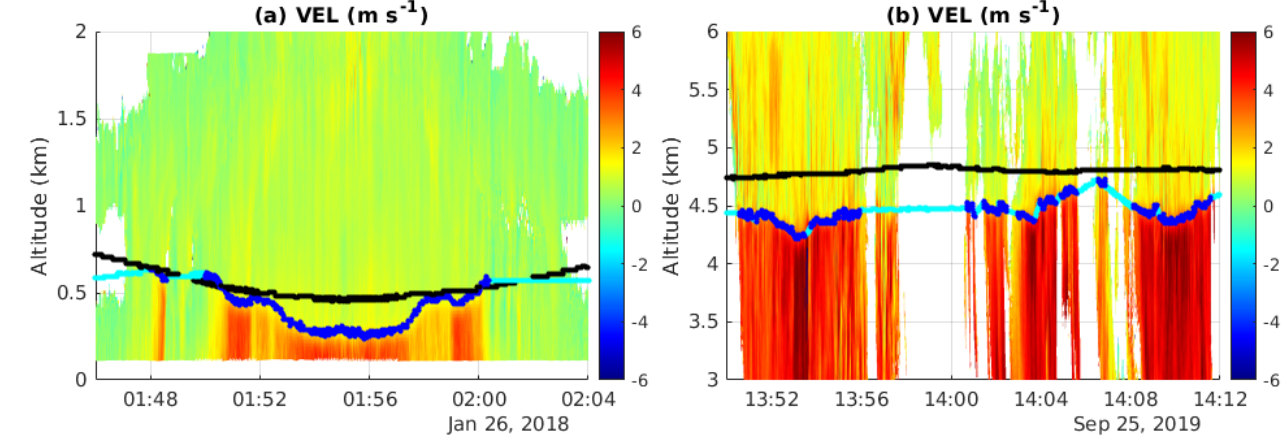
Figure 6. Radial velocity and melting layer data for examples where the melting layer is lowered towards the center of storms, collected during ( a ) SOCRATES and ( b ) OTREC. Colors as in Figure 5. Times are in UTC.